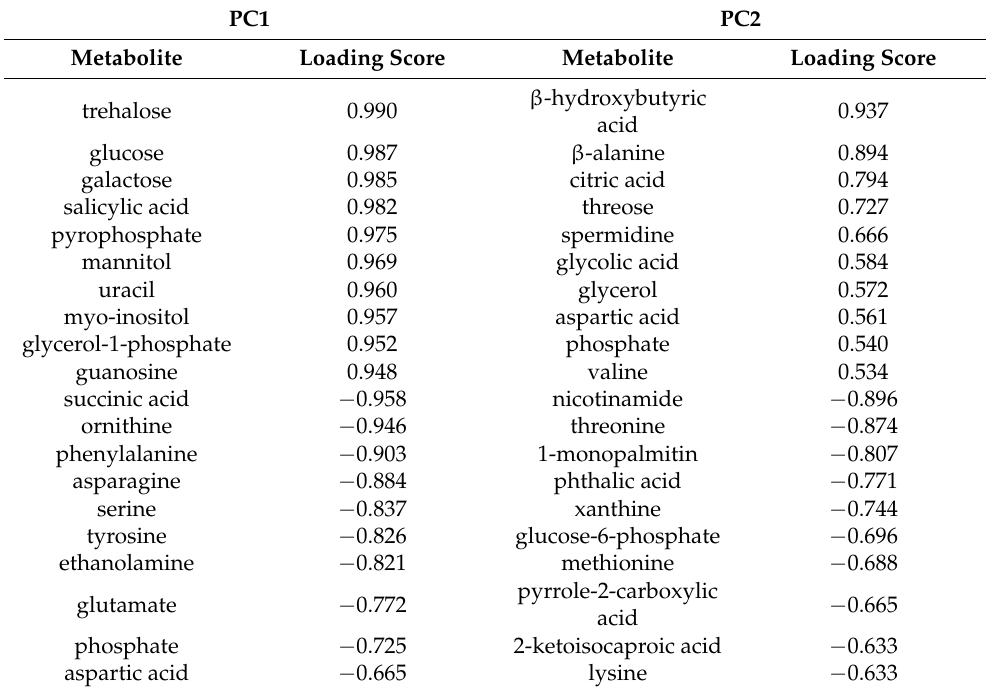
Table 1. Twenty metabolites with their high absolute loading scores on PC1 and PC2, as obtained by PCA.